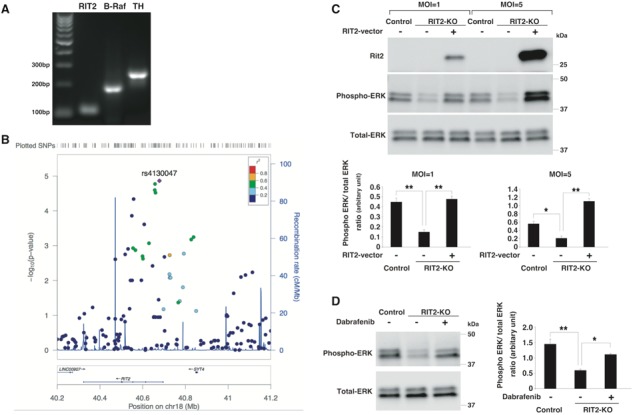
Significant association between RIT2 and PD, and the effect of dabrafenib on RIT2-knockout (KO) cells(A) RT-PCR data for the RIT2, BRAF and TH expression in the mouse substantia nigra. (B) Regional association plot of the RIT2 locus. (C) Immunoblot of phosphorylated ERK and Rit2. Phospho-ERK was reduced in RIT2-KO (clone 42) compared to control cells (clone 7), and overexpression of RIT2 in RIT2-KO cells rescued the phosphorylation of ERK. (Upper) representative immunoblots and (bottom) summarized data of phospho-ERK/total ERK levels in each cell line. (D) Dabrafenib upregulated the expression of phospho-ERK in RIT2-KO cells (clone 42). (Left) representative immunoblots and (right) summarized data of phospho-ERK/total ERK levels in each cell line. Data in (C) and (D) represent the mean ± s.e.m. (*, P-value < 0.05 and **, P-value < 0.01; one-way ANOVA with the Tukey post-hoc test; n = 3 per group).